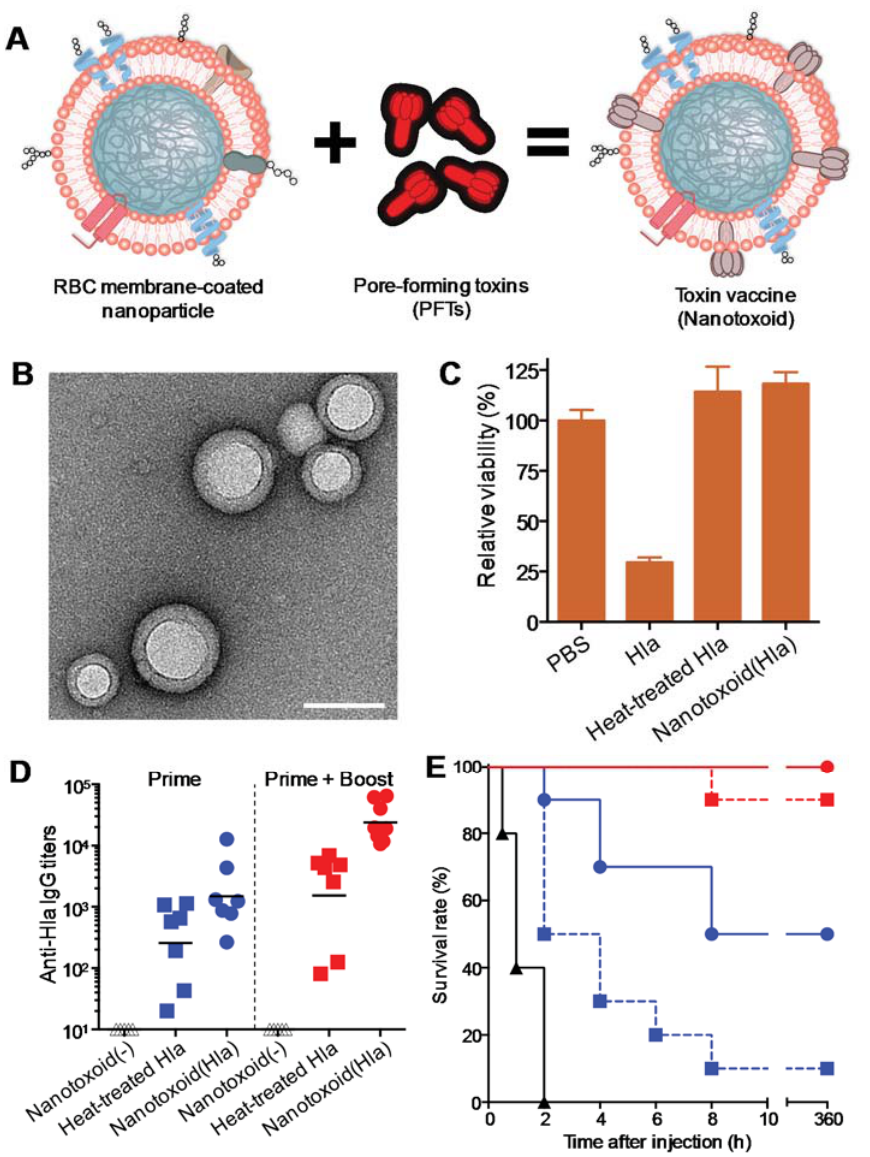
Figure 2. ( A ) Schematic preparation of nanoparticle-detained toxins, denoted “nanotoxoid”, consisting of substrate-supported RBC membranes into which pore-forming toxins (PFTs) can spontaneously incorporate; ( B ) A transmission electron microscopic (TEM) image of the particle vectors with uranyl-acetate staining (scale bar, 80 nm); ( C ) Toxicity of different Hl(cid:2) formulations against DCs derived from mice. The cells were incubated for 48 h with Hl(cid:2), heat-treated Hl(cid:2) (60 min) or nanotoxoid (Hl(cid:2)) at 15 (cid:3)g/mL Hl(cid:2) concentration. Cellular viability was assessed using an MTT assay ( n = 6); ( D ) Vaccination was conducted following two different schedules: a prime only on day 0 and a prime on day 0 plus two booster vaccinations on day 7 and day 14, respectively. Anti- Hl(cid:2) IgG titers in the vaccinated mice were quantified on day 21 ( n = 7); ( E ) Survival rates of mice over a 15-day period following intravenous injections of 120 (cid:3)g/kg Hl(cid:2) on day 21 via the tail vein ( n = 10). The unvaccinated mice were used as a negative control and mice vaccinated with heat-treated Hl(cid:2) served as positive controls. Reproduced with permission from Reference